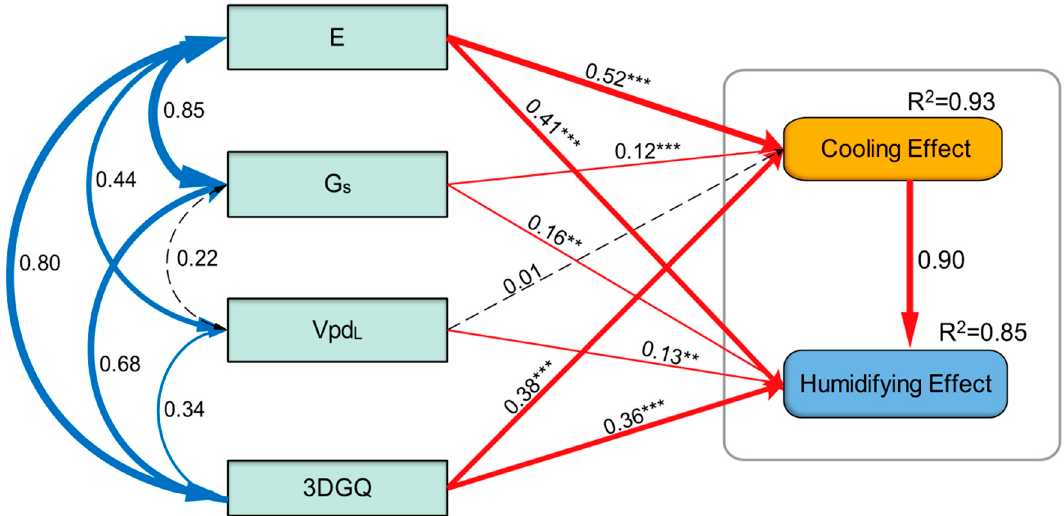
Figure 10. The structural equation model (SEM) shows the direct and indirect effects of various factors on the microclimate regulation ability of urban trees. The value of the arrow is the normalized path coefficient, indicating the degree of influence of the correlation. The red solid arrow indicates the important relationships in the model, the blue solid arrow indicates the positive correlation, and the black virtual arrow indicates that there is no significant correlation. The R 2 value represents the ratio of the explanatory variance. The path coefficient is estimated by maximum likelihood and the fitness of the chi-square test model is tested. Significance level: * p < 0.01, ** p < 0.001. E: transpiration rate; G s : stomatal conductance; 3DGQ: three dimensional green quantity; Vpd L : vapor pressure deficit.